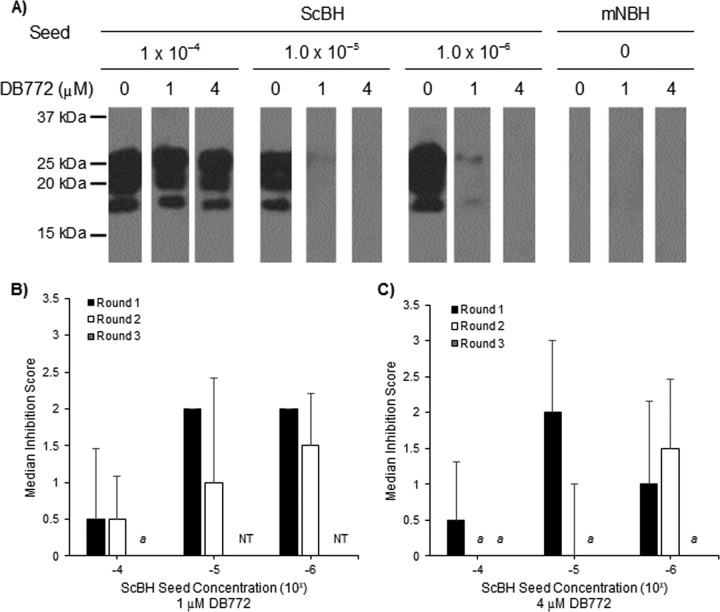
DB772 inhibits PrPSc-seeded misfolding during serial PMCA assay. The inhibition of PrPSc-seeded misfolding was evaluated by sPMCA assay by treating mNBH with either 1 or 4 μM DB772. Treated reaction mixtures were seeded with 10−4, 10−5, or 10−6 dilutions of 10% ScBH and processed for 4 rounds. Reaction mixtures were collected at each round and tested for PK-resistant PrPSc by immunoblotting. PMCA rounds were normalized to the initial round of PrPSc detection (i.e., the initial round of detection corresponds to round 1n). (A) A representative immunoblot from samples collected at round 1n is demonstrated. Band intensities were quantified by densitometry. (B and C) Densities of bands from DB772-treated reaction mixtures were normalized to those of vehicle control (0.4% DMSO) to obtain a percent reduction categorical score for DB772 at 1 μM (B) and 4 μM (C). Data columns represent the median score ±1 standard deviation. a, all three replicates scored 0. NT, reaction mixtures seeded with 10−5 or 10−6 ScBH and treated with 1 μM DB772 were not tested at round 3n.